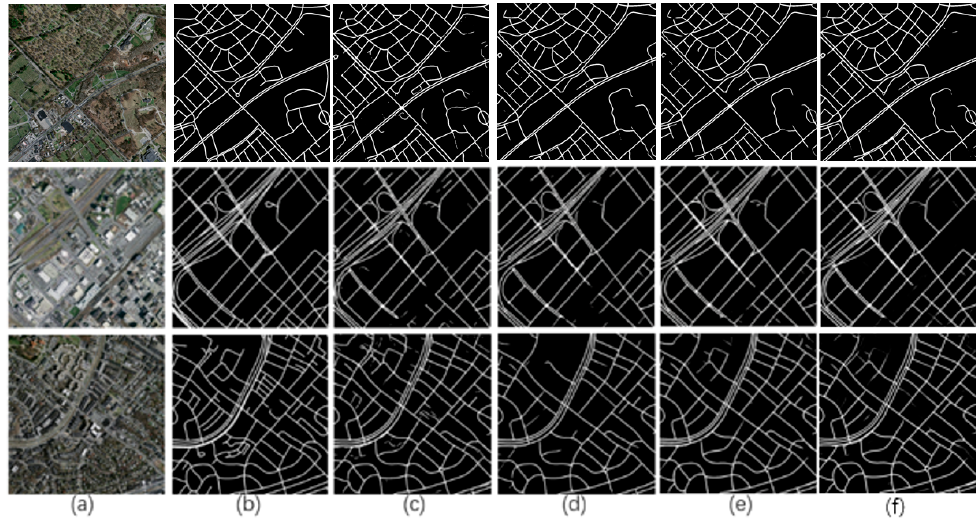
Figure 16. Road extraction results in complicated scene images ( a ) input image; ( b ) label image; ( c ) D-linkNet; ( d ) S-DenseNet; ( e ) SD-DenseNet; ( f ) SDG-DenseNet.